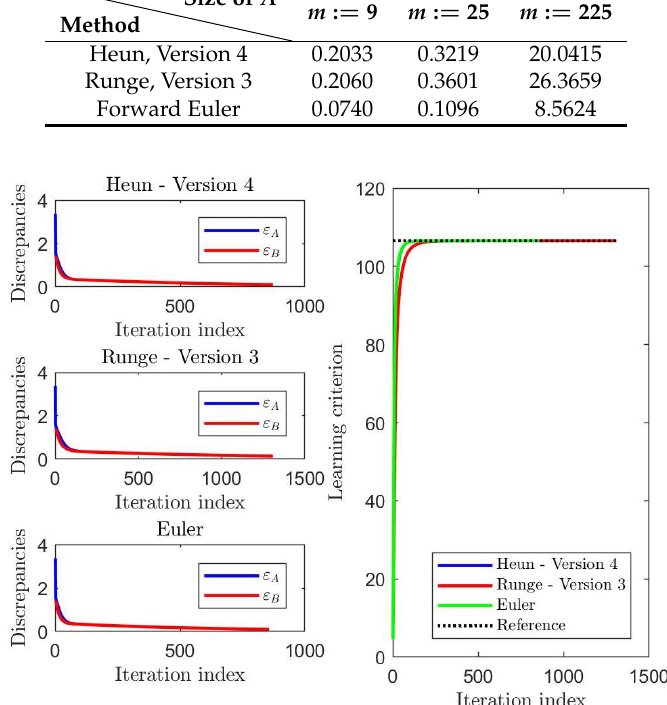
Figure 3. Results of a comparison of the values taken by the discrepancies and the learning criterion